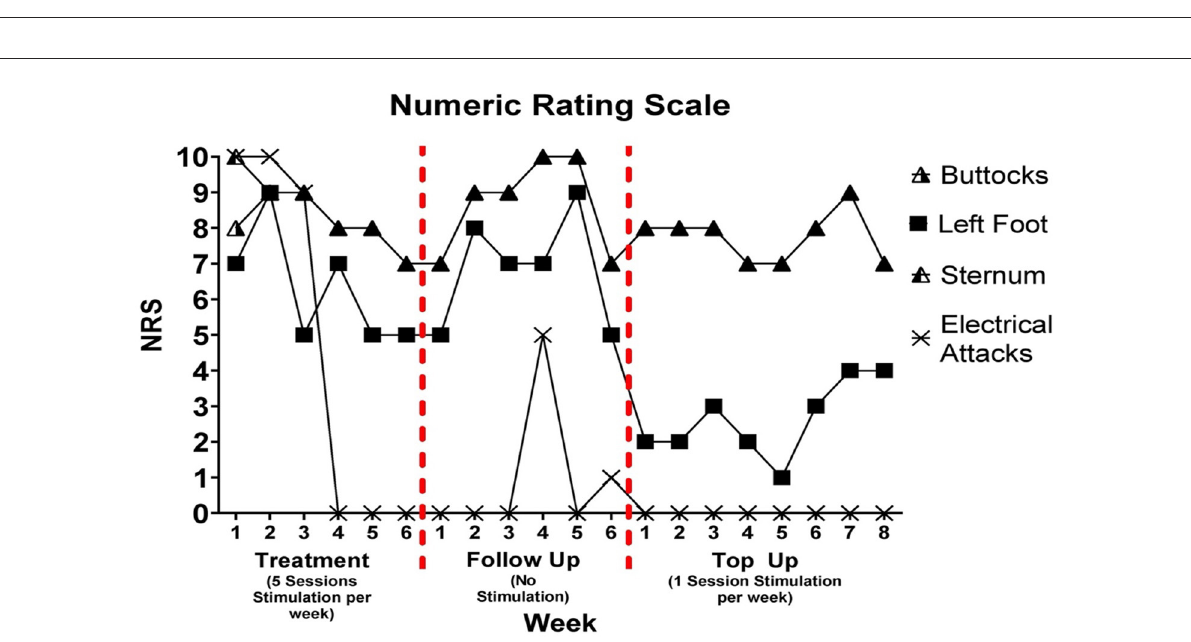
FIGURE2 Numeric ratings scale was delivered once per week during treatment, follow up, and top up sessions. There was a 5-week period between follow up week 6 and top up session week 1. It is important to note that pain rating for buttock and sternum differed on week 1 of treatment; however, the rating was the same for both pain locations at each subsequent assessment. A filled in triangle indicates that the pain rating was the same for buttocks and